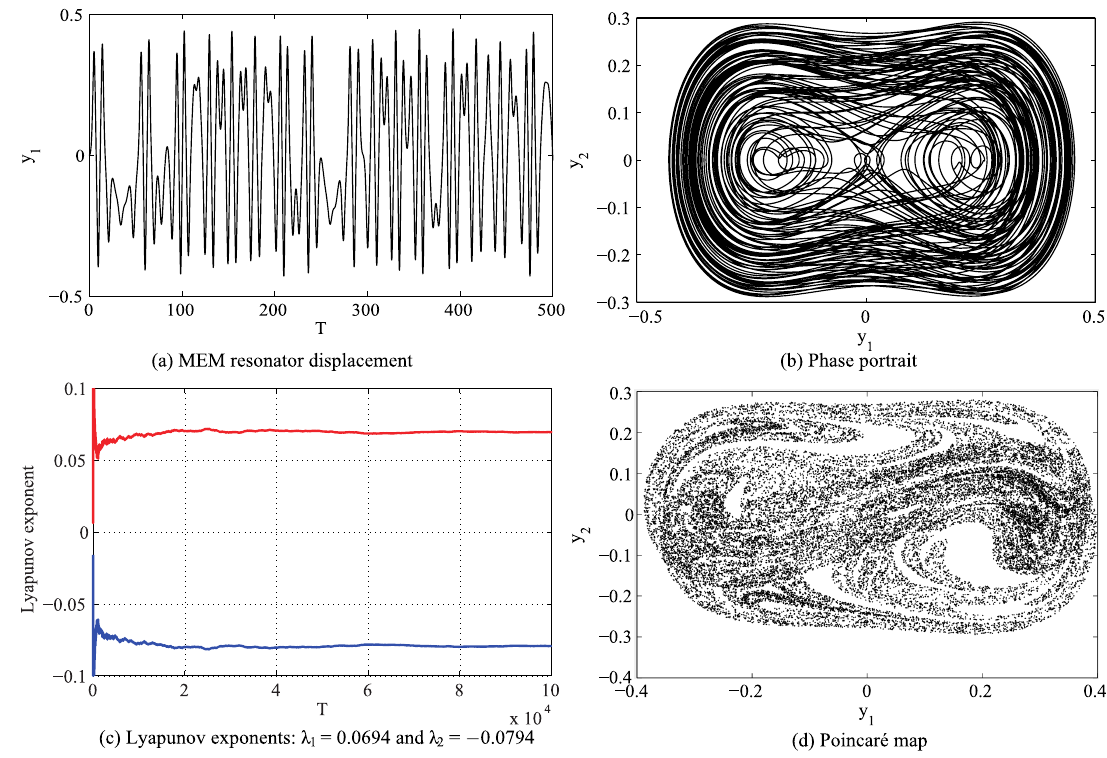
Fig. 2. Micromechanical resonator dynamics without